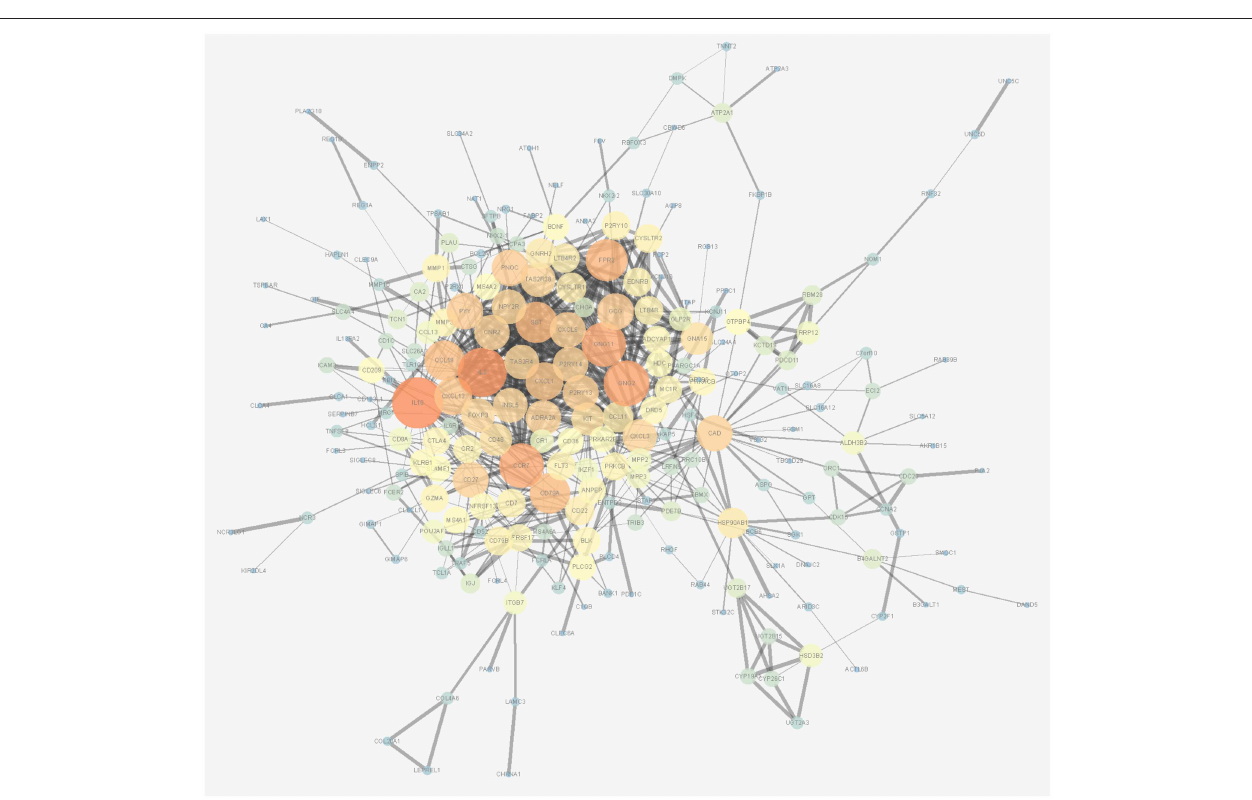
FIGURE 3 | Protein-protein interaction network of overall survival-associated mRNAs generated by Cytoscape. The size and brightness of the circle represent the degree of the connection. The larger and brighter circles represent hub genes in the network. The thickness of the lines represents the combined score.